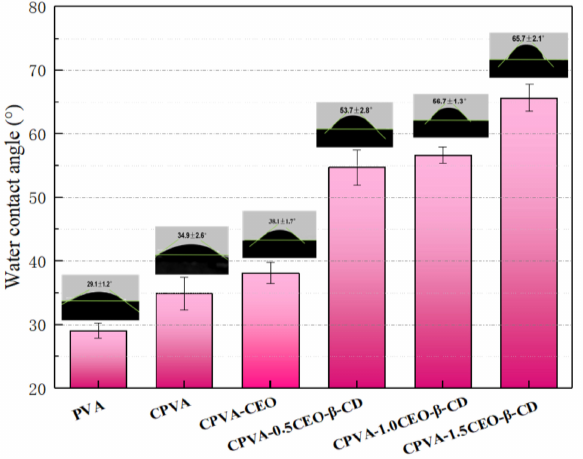
Figure 10. The water-contact angle of various samples. Adapted from [135] with the Copyright permission of